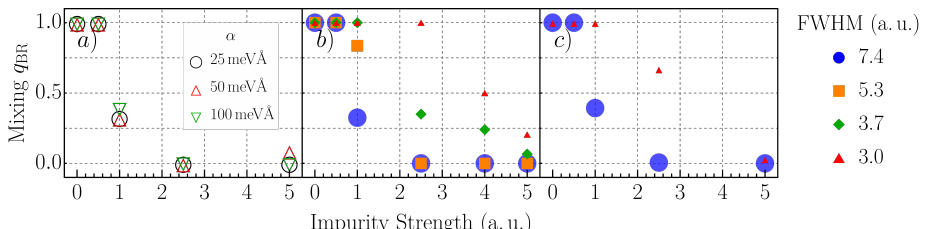
Figure 1. The mixing parameter q BR as it enters Equation (4). We consider a 2DEG confined to a square with infinite boundaries with a size of 100 × 100a.u., which contains ten randomly distributed Gaussian impurities with varying strengths and FWHM, as indicated. A magnetic field with a strength of B = 500mT is applied transverse to the 2DEG. Panel ( a ) shows the dependence on the strength α of the Rashba SOC for a fixed FWHM = 7.4a.u. of the Gaussian impurities. Panels ( b , c ) show the dependence of q BR on the impurities’ strength and FWHM for α = 25 in ( b ) and meVÅ and α = 100meVÅ in ( c